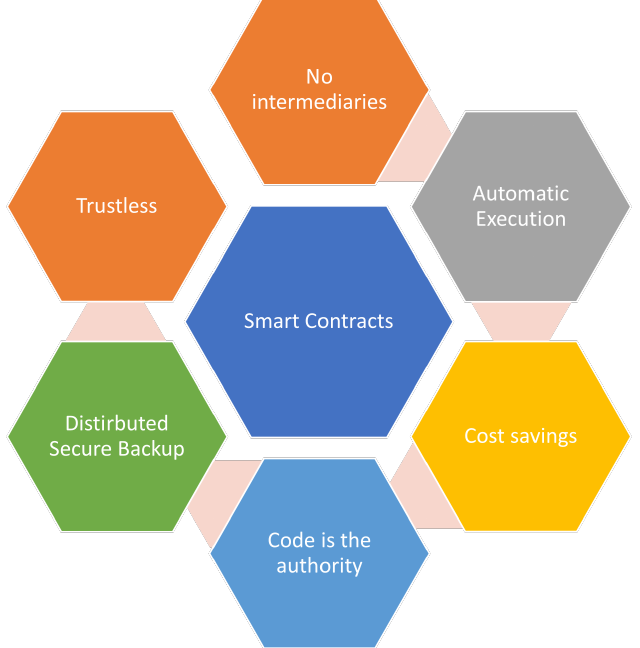
Figure 3. Important characteristics of a smart contract deployed on a blockchain